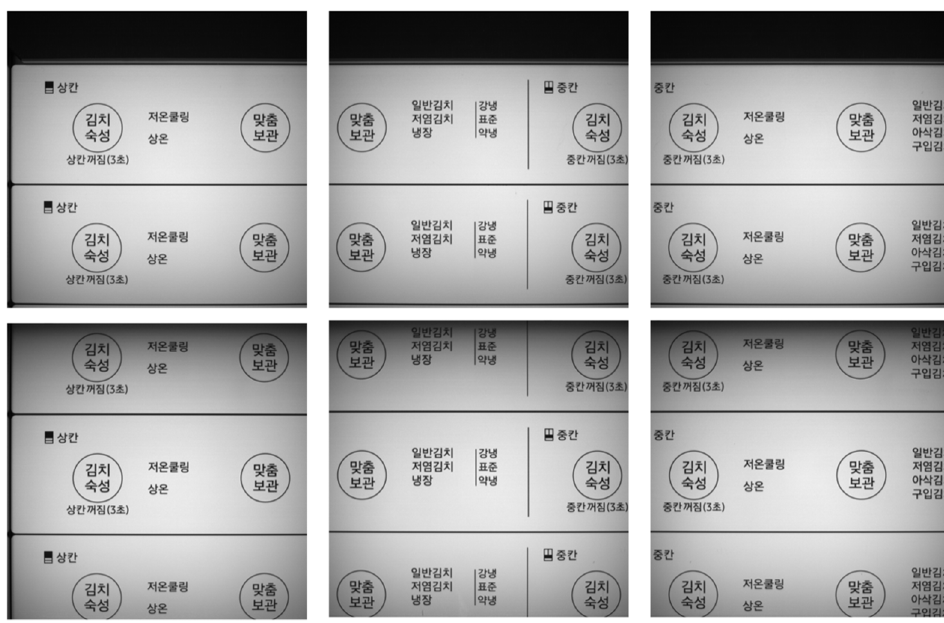
Figure 15. Data acquisition method.